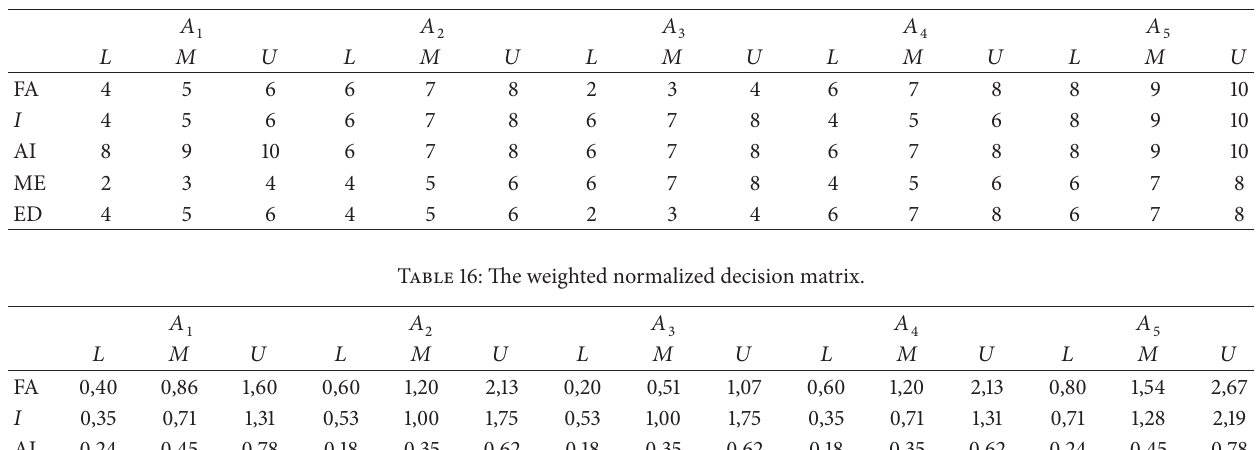
Table 15: Decision matrix for alternatives in fuzzy TOPSIS.